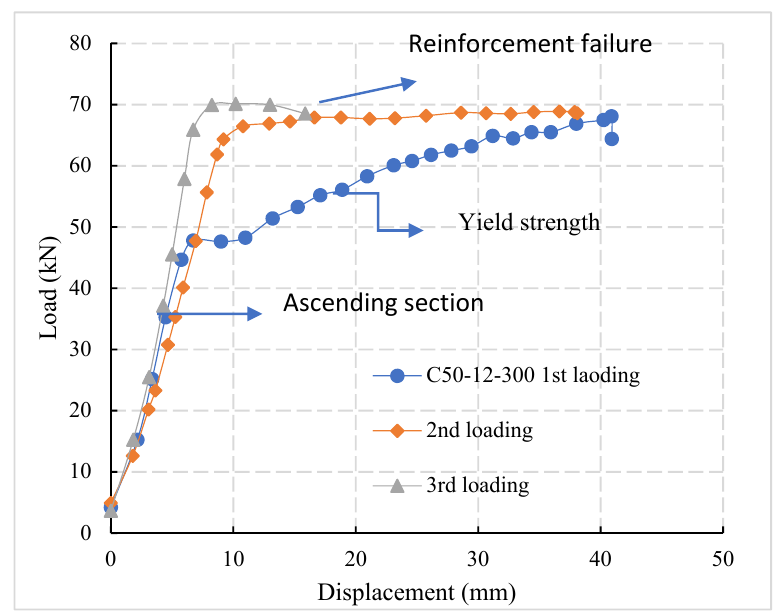
Figure 3. Load-displacement curve-tensile failure of reinforcement.